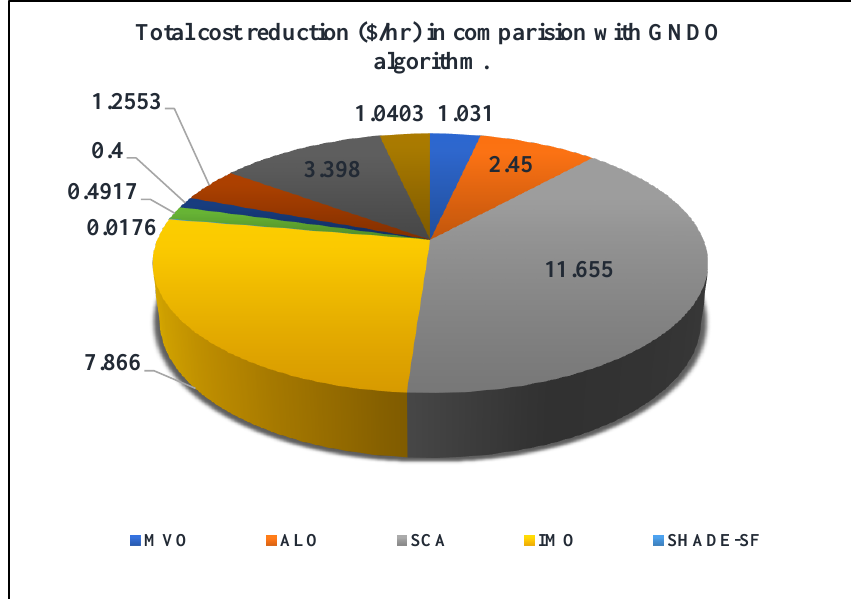
Figure 17. Comparison of the TFC reduction ($/h) with other algorithms.